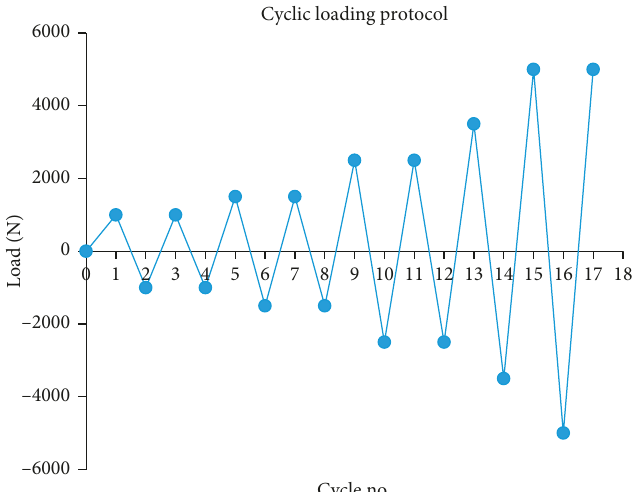
Figure 4: The cyclic loading